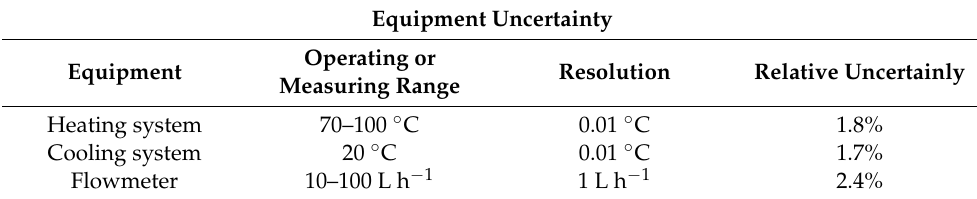
Table 2. Uncertainty analysis of the equipment used in this